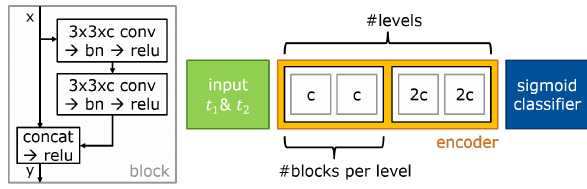
Figure 3. Proposed residual network. small network with only around 750,000 trainable